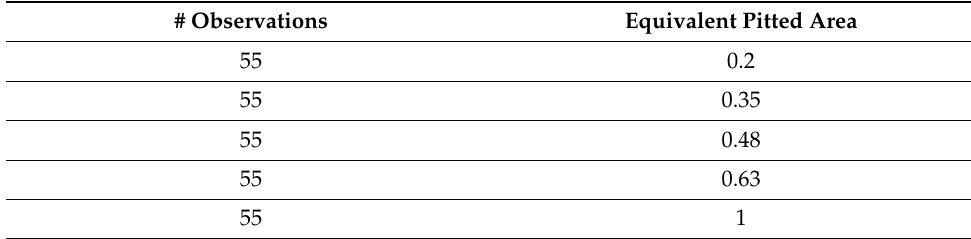
Table 7. Training-set composition for damage quantification.